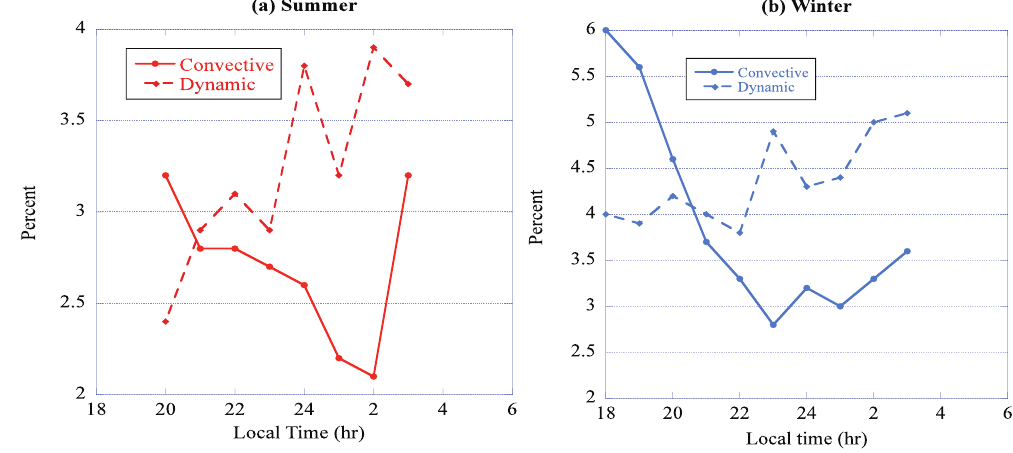
Fig. 6. The local time dependent probability of instabilities detected by the CSU Na lidar between 83 and 91km in (a) summer and (b)